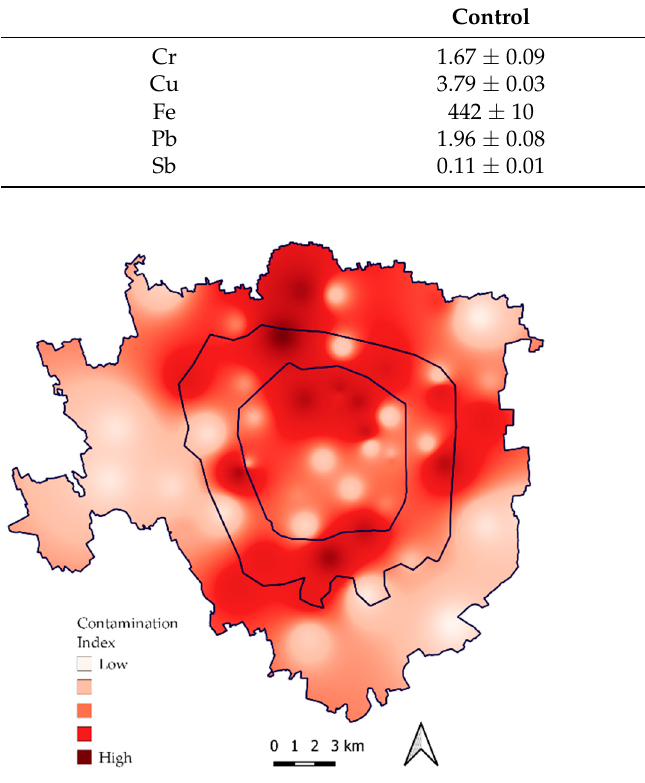
Figure 6. Map of the contamination index obtained from the bioaccumulation of selected trace elements, modified after [28].